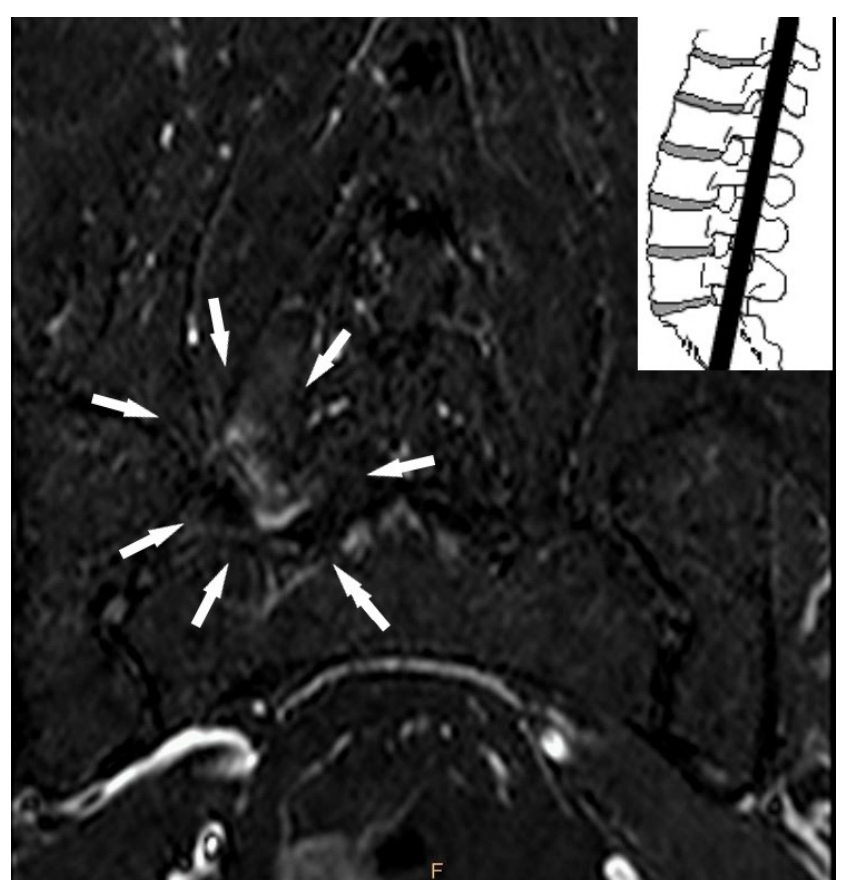
Figure 2. Axial short tau inversion recovery (STIR) T2-weighted sequence showing right L5-S1 facet joint bone marrow edema signal (white arrows).